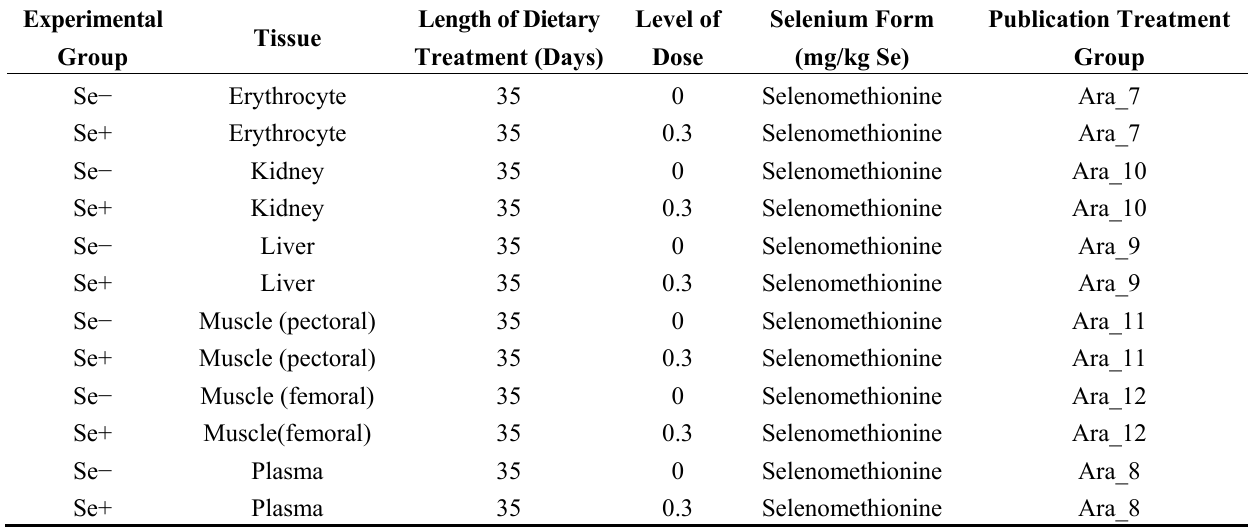
Table 1. An example of coding treatments within a publication